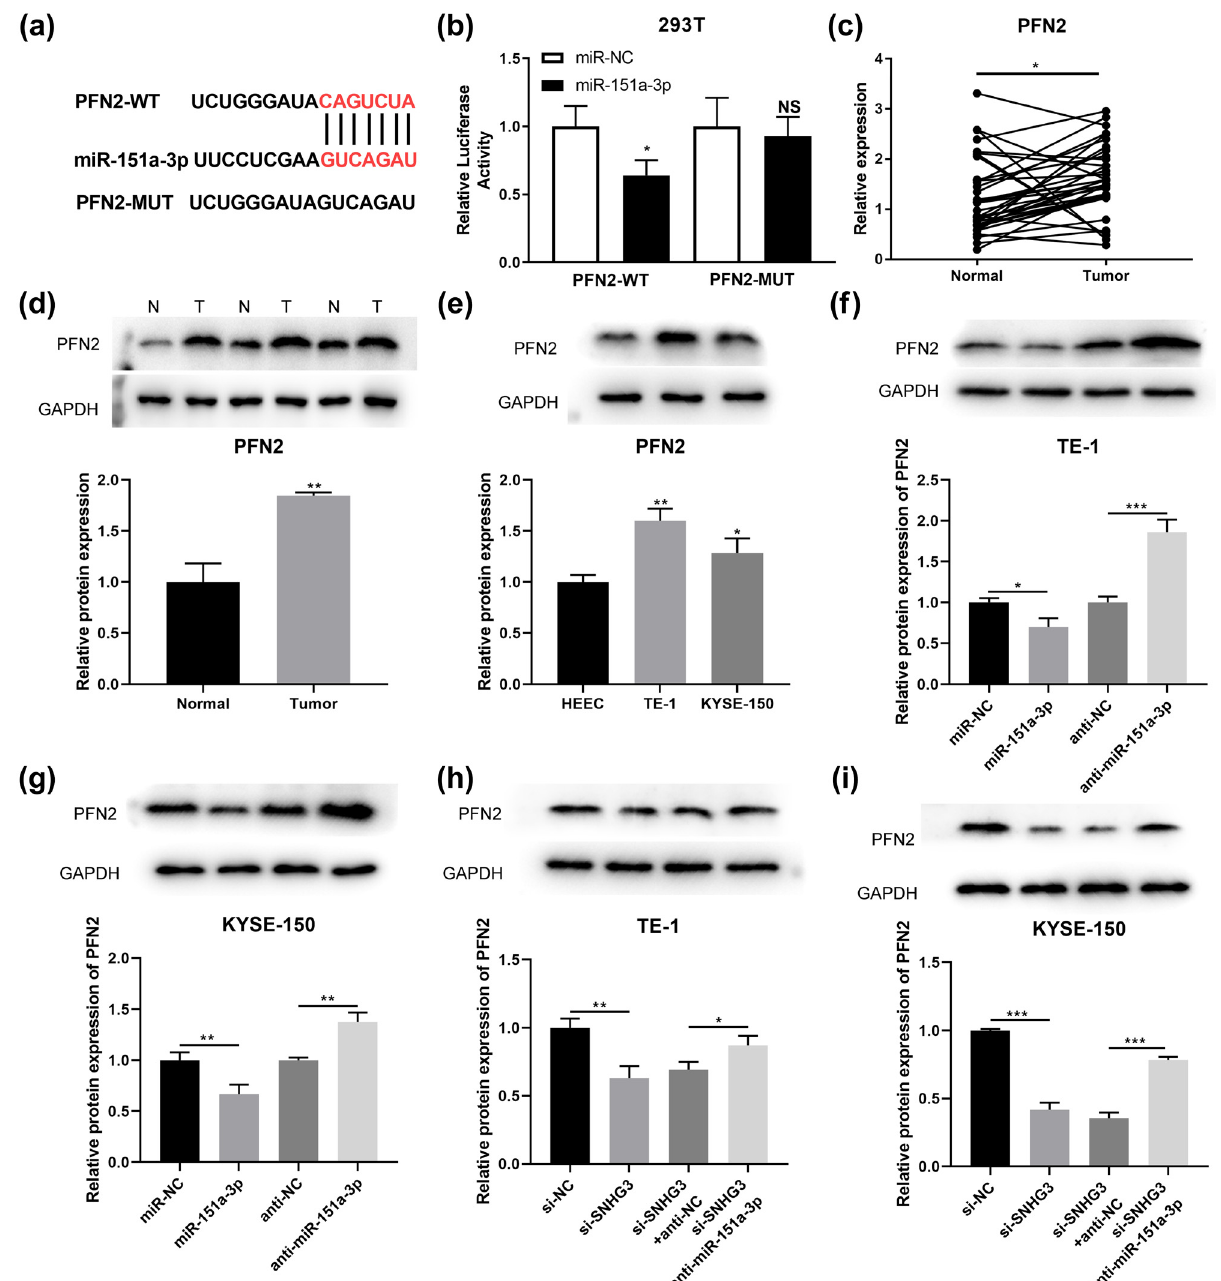
Figure 5: PFN2 was a downstream target of miR - 151a - 3p. ( a ) The potential binding sites between miR - 151a - 3p and PFN2. ( b ) The combination between miR - 151a - 3p and PFN2 was veri fi ed by dual luciferase reporter assay. ( c ) The mRNA levels of PFN2 in tumor tissues and non - tumor tissues. ( d ) The protein levels of PFN2 in tumor tissues and non - tumor tissues. ( e ) The protein levels of PFN2 in TE - 1 and KYSE - 150 cells. ( f and g ) The protein levels of PFN2 in ESCC cells transfected with miR - NC, miR - 151a - 3p, anti - NC or anti - miR - 151a - 3p were measured. ( h and i ) After ESCC cells were transfected with si - NC, si - SNHG3, si - SNHG3 + anti - NC, or si - SNHG3 + anti - miR - 151a - 3p, the protein levels of PFN2 were measured. * P < 0.05, ** P < 0.01, *** P <